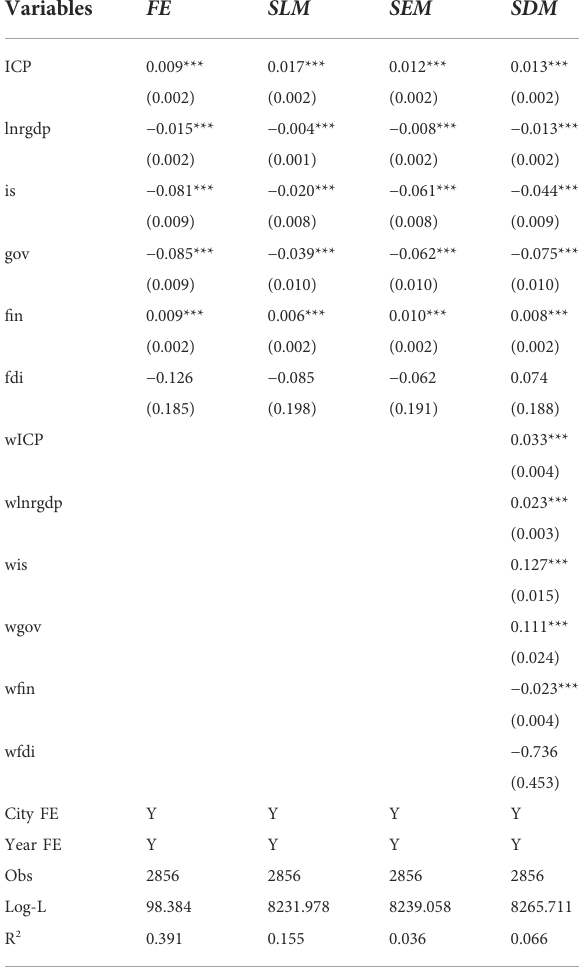
TABLE 4 Impact of innovative city pilots on urban carbon emission performance.